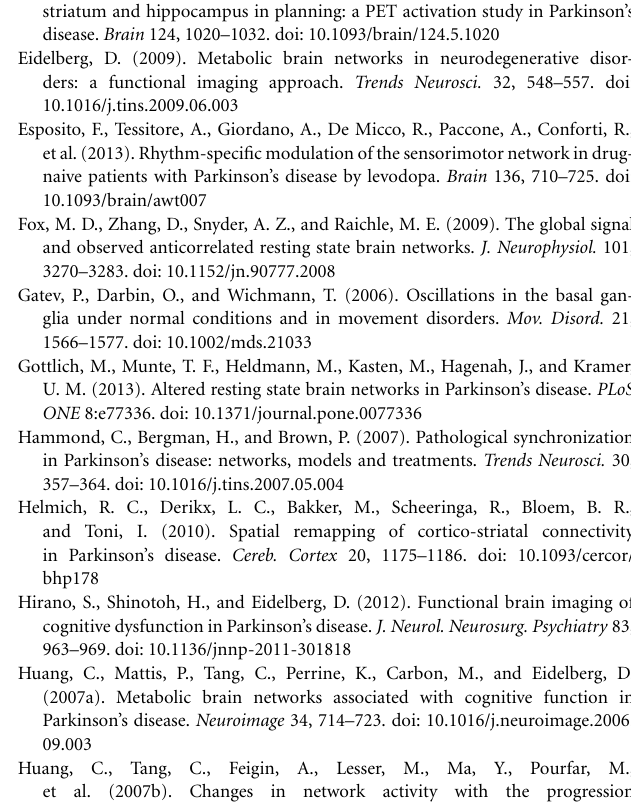
Figure S2 | Automated meta-analysis workflow. An automated search